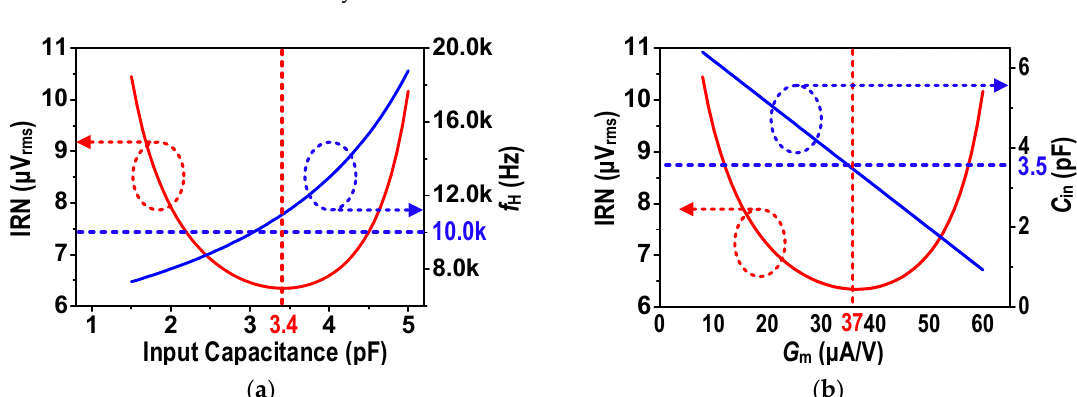
Figure 4. AC-coupled single-ended input and output LNA simulation results with the given 75 μ m 2 : ( a ) input referred noise (IRN) and f H versus C in ; ( b ) IRN and C in versus G m .